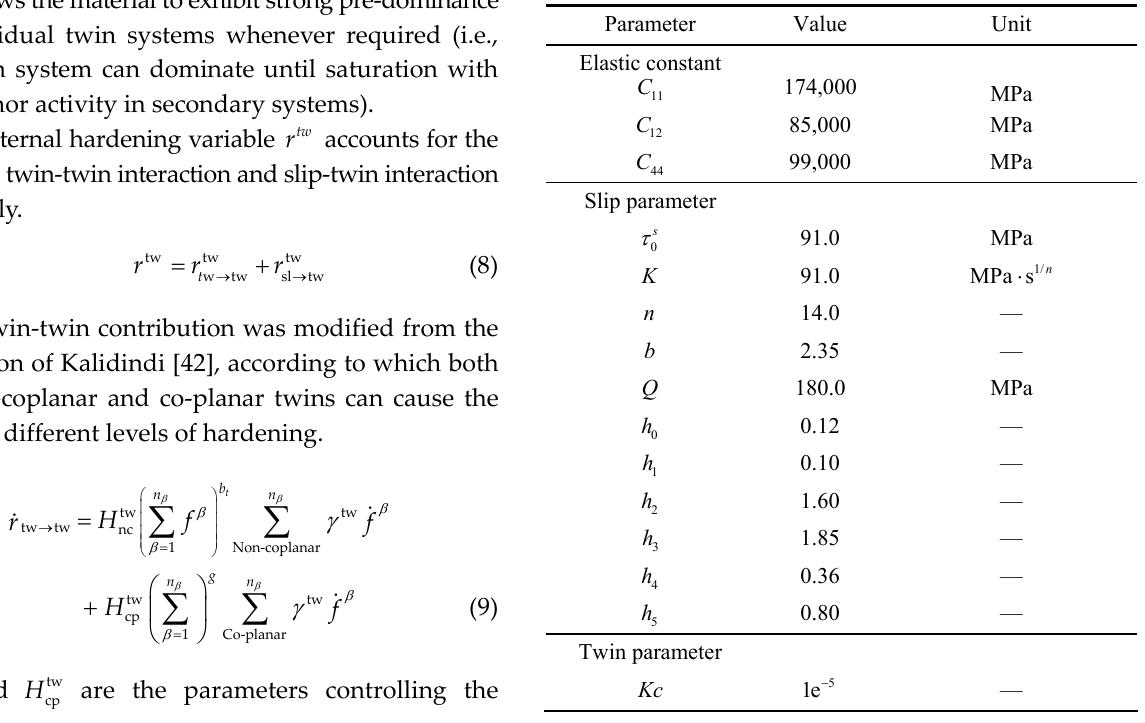
Table 1 Model parameters for the 16.5% Mn, 1.05% C Hadfield steel, Reproduced from Ref.